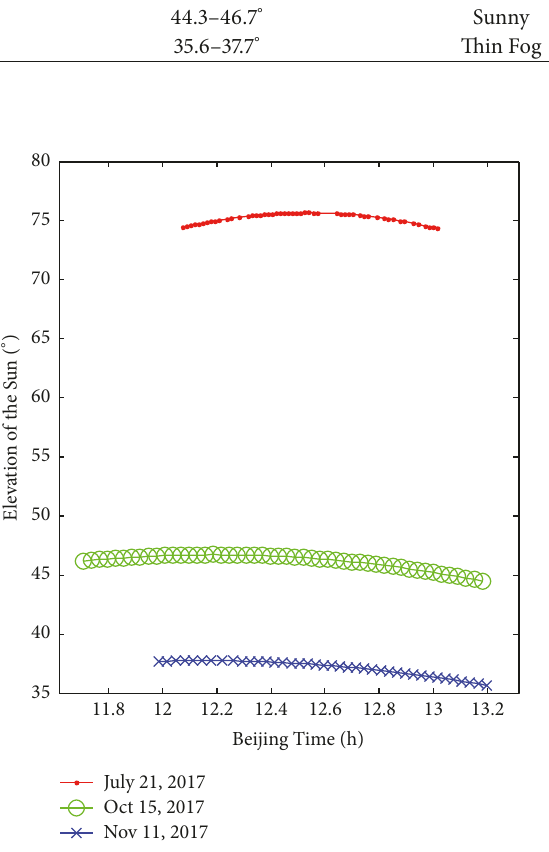
Figure 11: Times series of the predicted elevations of the